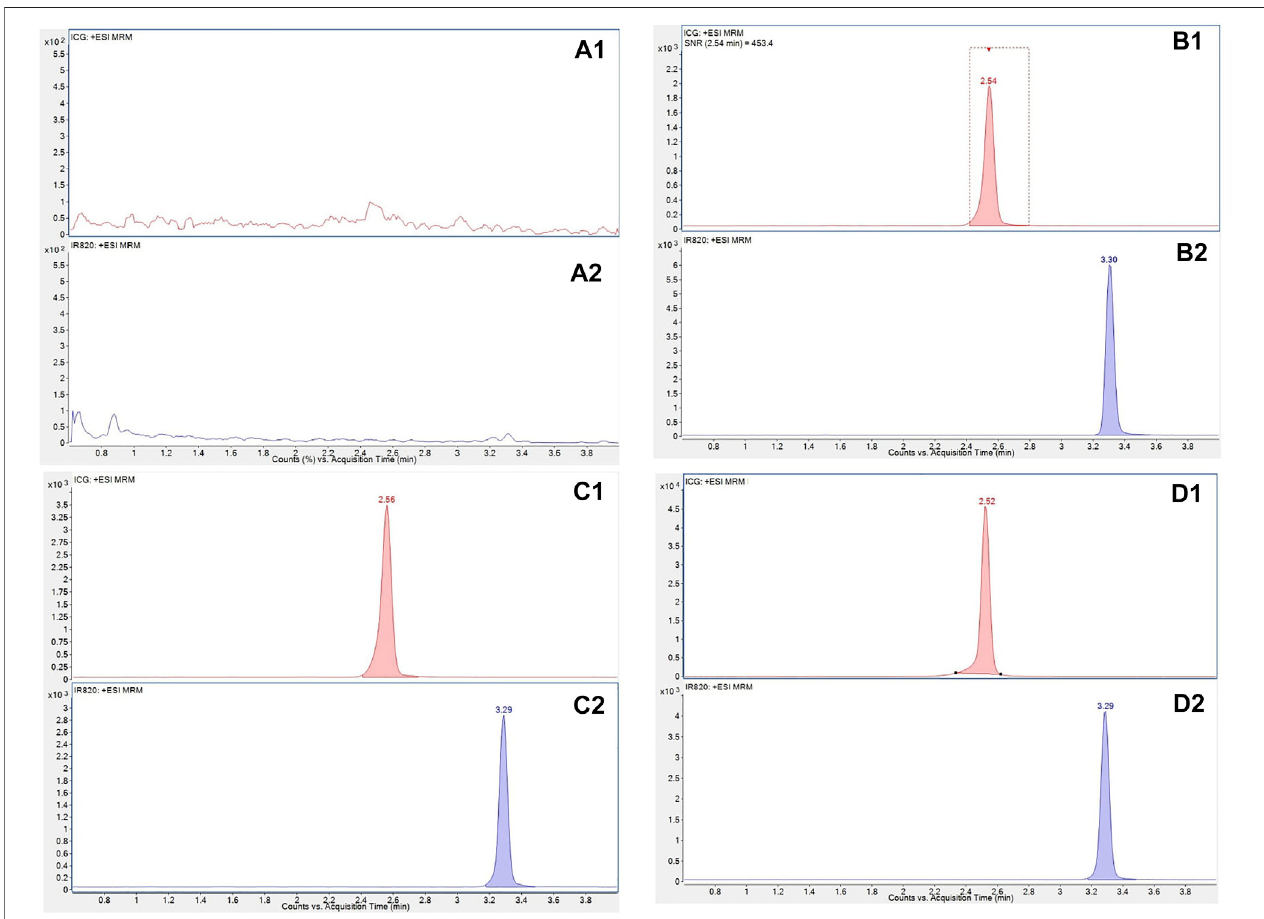
FIGURE 3 | Representative SRM chromatograms of ICG (A1) and IR-820 (A2) in blank murineliver tissue; in murine liver tissues samples spiked with (50.0 ng/ml) showingareactiontime(RT)2.6 min (B1) ;andwithIR-820(500 ng/ml)showingaRT3.3 min (B2) .RepresentativeSRMchromatogramsoftissuesamplesobtained2 hpost injection from mice treated with free ICG (C1) and HFn-ICG (D1) . For the two types of treatment, the SRM chromatograms for IR-820 are presented in (C2) and (D2)